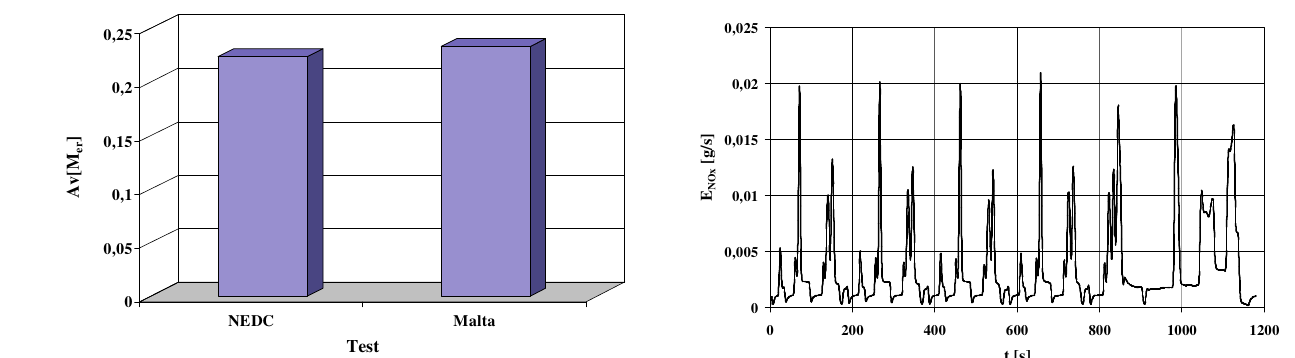
Fig. 11. The emission intensity of nitrogen oxides in the NEDC test